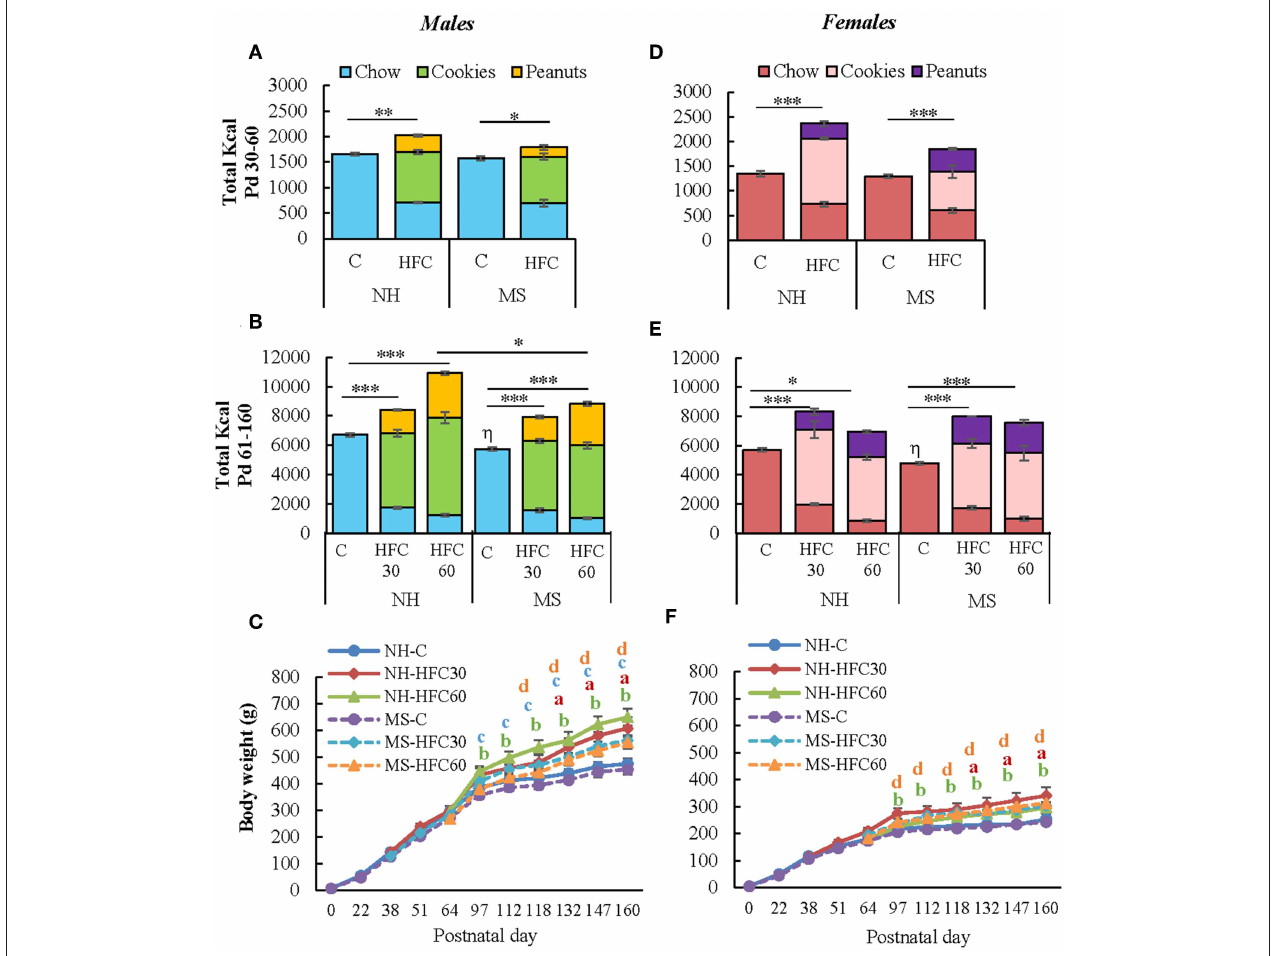
FIGURE 2 | Effect of maternal separation and a high-fat/high-carbohydrate diet on food intake and body weight. Male and female pups were non-handled (NH) or separated from the dam (MS) daily from postnatal day 2–21 (Pd) for 3h. NH and MS rats had free access to either chow (C) or a high-fat/high-carbohydrate diet (HFC: cookies, peanuts, and chow) from Pd30 (HFC30) or 60 (HFC60) until Pd160. Total kilocalorie intake during the juvenile period (A,D) and adulthood (B,E) . (C,F) Body weight of male and female rats from birth until Pd160. Food intake was calculated by dividing the daily kilocalorie intake per cage by the number of rats in the cage (two rats/cage). Data are expressed as mean ± S.E.M. and were analyzed by a three-way ANOVA to determine effects of neonatal stress, diet, sex, and the interaction of these variables. If a significant main effect or interaction was found, ANOVA was followed by the Holm–Sidak multiple comparisons test; the level of significance was set at p < 0.05. * p < 0.05, ** p < 0.01, *** p < 0.001, η vs. NH-C, a NH-HFC30 vs. NH-C, b NH-HFC60 vs. NH-C, c MS-HFC30 vs. MS-C, d MS-HFC60 vs. MS-C. NH-C n = 6/sex, NH-HFC30 and NH-HFC60 n = 7/sex, MS-C n = 6/sex, MS-HFC30, and MS-HFC60 n =